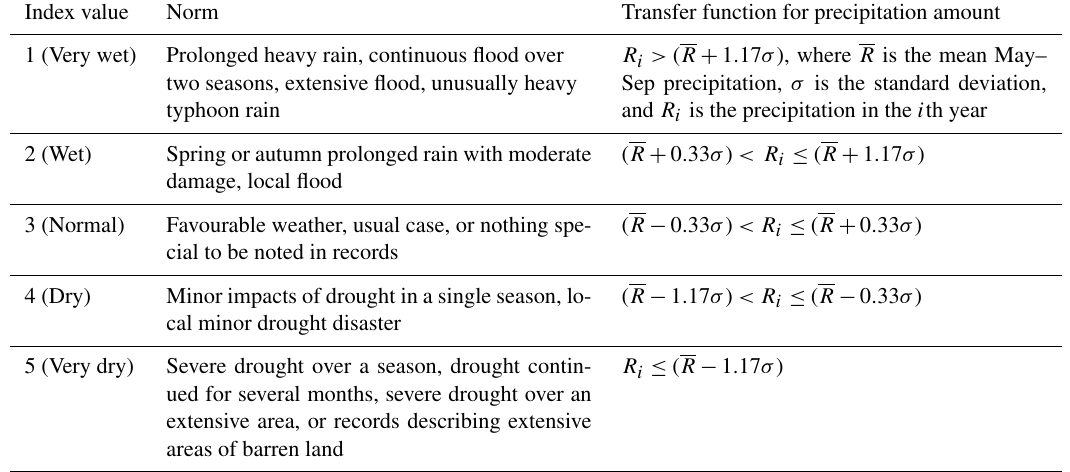
Table 4. Criteria used in the generation of five-point drought–flood indices in China (Academy of Meteorological Science of China Central Meteorological Administration, 1981). For more details, see Zhang and Crowley (1989), Zhang et al. (1997), and Yi et al.